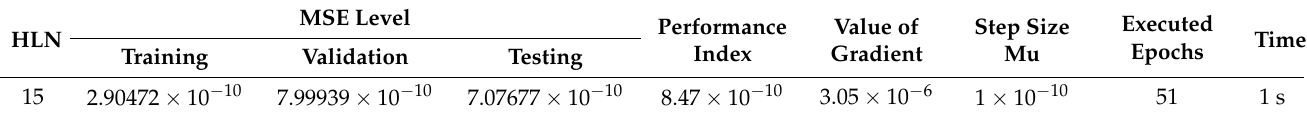
Table 6. ANNLMB outcomes of scenario 4 for heat transfer in spinning nanofluid.